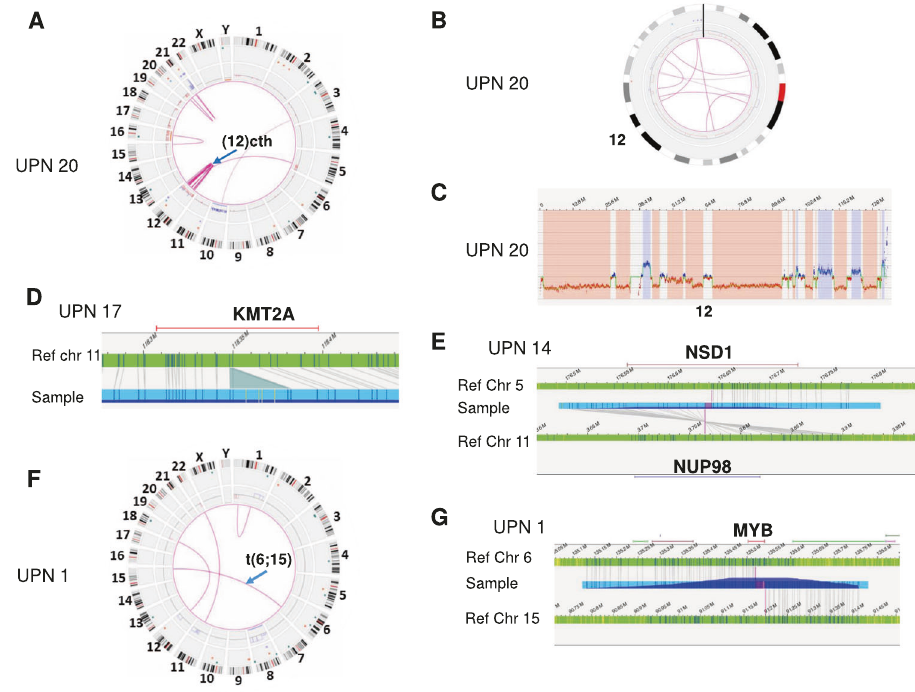
Fig. 2 Examples of recurrent cytogenetic abnormalities detected by OGM in MDS/AML. A – C OGM results of UPN 20. A Circos plot revealing chromothripsis affecting the chromosome 12 (blue arrow). B Circos plot focusing on chromosome 12 showing multiple translocations (pink lines), gains (blue boxes), and losses (red boxes) affecting the chromosome 12. C CNV pro fi le of the chromosome 12 showing multiple gains (blue boxes) and losses (red boxes). D Fine mapping of the long arm of chromosome 11 in UPN 17 indicating an insertion at 11q23.3 in KMT2A interpreted as KMT2A partial tandem duplication. E Fine mapping of the chromosomes 5 and 11 in UPN 14 indicating a translocation t(5;11) (q35.3;p15.4)(176625935;3755942) with a breakpoint located in NSD1 on 5q35.3 and NUP98 on 11p15.4. F , G OGM results of UPN 1. F Circos plot showing a balanced translocation between chromosomes 6 and 15 (blue arrow). G Fine mapping of the chromosomes 6 and 15 indicating a translocation t(6;15)(q23.3;q26.1)(135519170;91199438) with a breakpoint located in MYB on